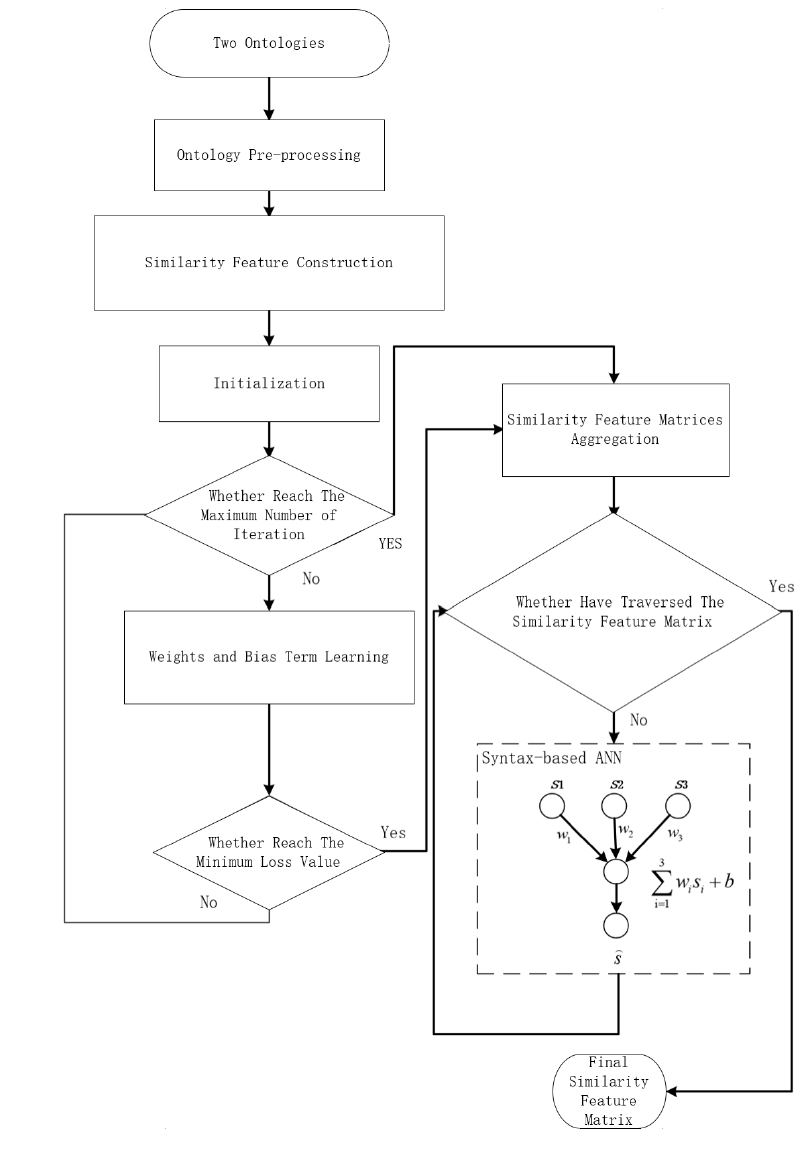
Figure 5. The Flow Chart of Syntax-based ANN Ontology Matching